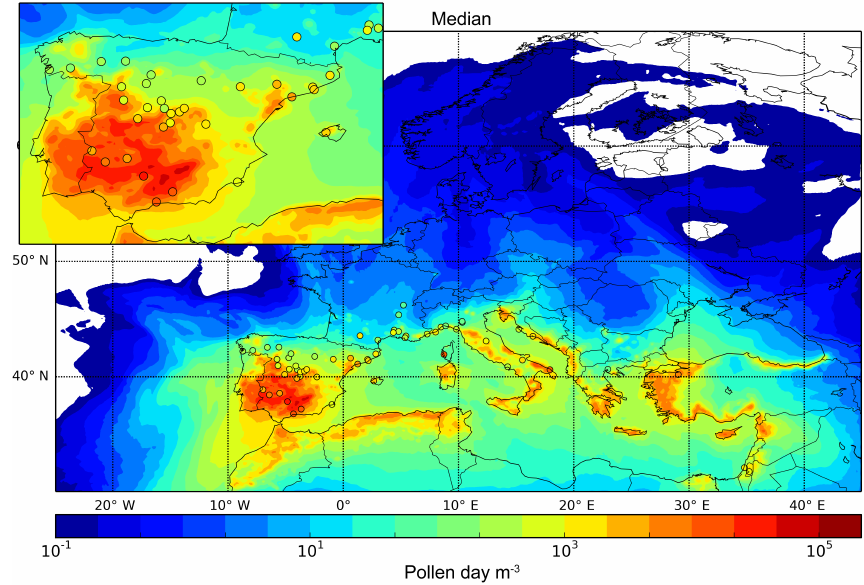
Figure 3. Observed (dots) and median-model-predicted (shades) seasonal pollen index (SPI, sum of daily concentrations), 2014 [pollen daym − 3 ].